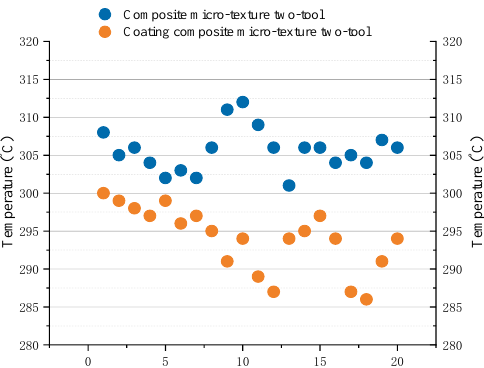
Figure 14. Comparison of cutting temperature of coated and non-micro–textured tools.